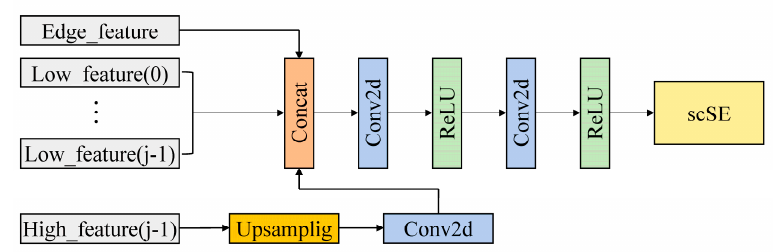
Figure 3. The structure of the j -th unit in the MEC block.